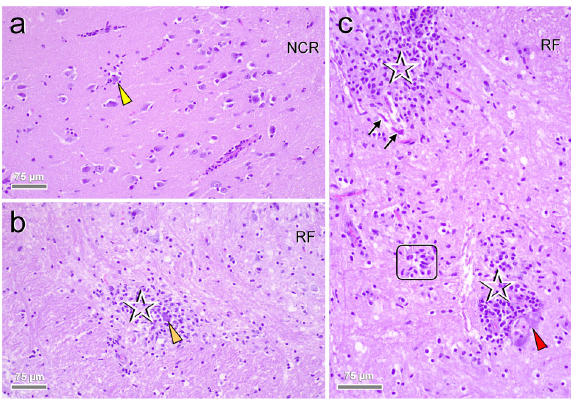
Fig. 5 | Close-up pathology and cellular damage of rustrela virus (RusV) infec- tionwithinthebrain. Infectedbrainsshowneurons( a – c :arrowheads)with( c :red arrowhead) and without ( a , b : yellow and orange arrowheads) degenerative fea- tures, early ( a , b : yellow and orangearrowheads) and advanced ( c : red arrowhead) neuronophagiasuggestiveofaneuronotropicpathogen.Focaldropoutofneurons is accompanied by microglial stars ( c : frame). In fl ammatory in fi ltrates ( b , c : aster- isks) mingle with focal glial proliferates. Dystrophic axons ( c : black arrows) are occasionally present within the perilesional area. Stain: haematoxylin eosin (H.E.). Anatomical landmarks: NCR: neocortical ribbon; RF: reticular formation. Cats: a SWE_06; b , c SWE_04.RepresentativeimagesofRusV-infectedcatsarepresented. All case and control cats ( n =29 each) were analysed. Histopathological diagnoses are provided in Supplementary Tables 3 and